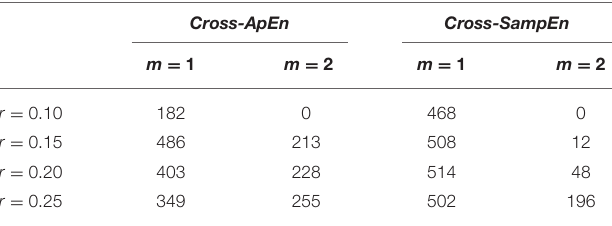
TABLE 3 | Total number of significant connections among the three groups (FDR-corrected p -values < 0.05, Kruskal-Wallis test) for each parameter combination in the training set.